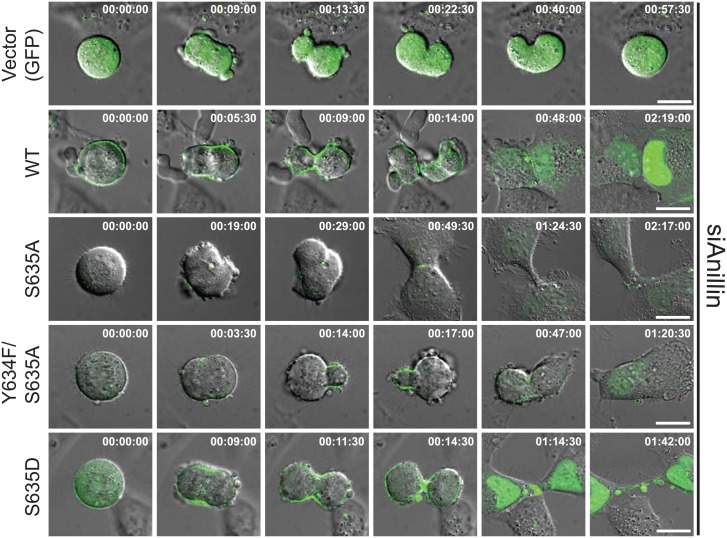
Timelapse videomicroscopy of anillin mutants.To assess contractile rings in live cells, timelapse videomicroscopy was performed in HeLa cells in which endogenous anillin was depleted and the GFP-tagged constructs were transiently transfected. The merge of DIC and GFP are shown. GFP signal is scaled equivalently among all constructs. Times from anaphase onset is reported (hours:min:sec) in the upper right of each panel. Scale bar, 10 μm. See also S4 Fig and Supplementary Videos.